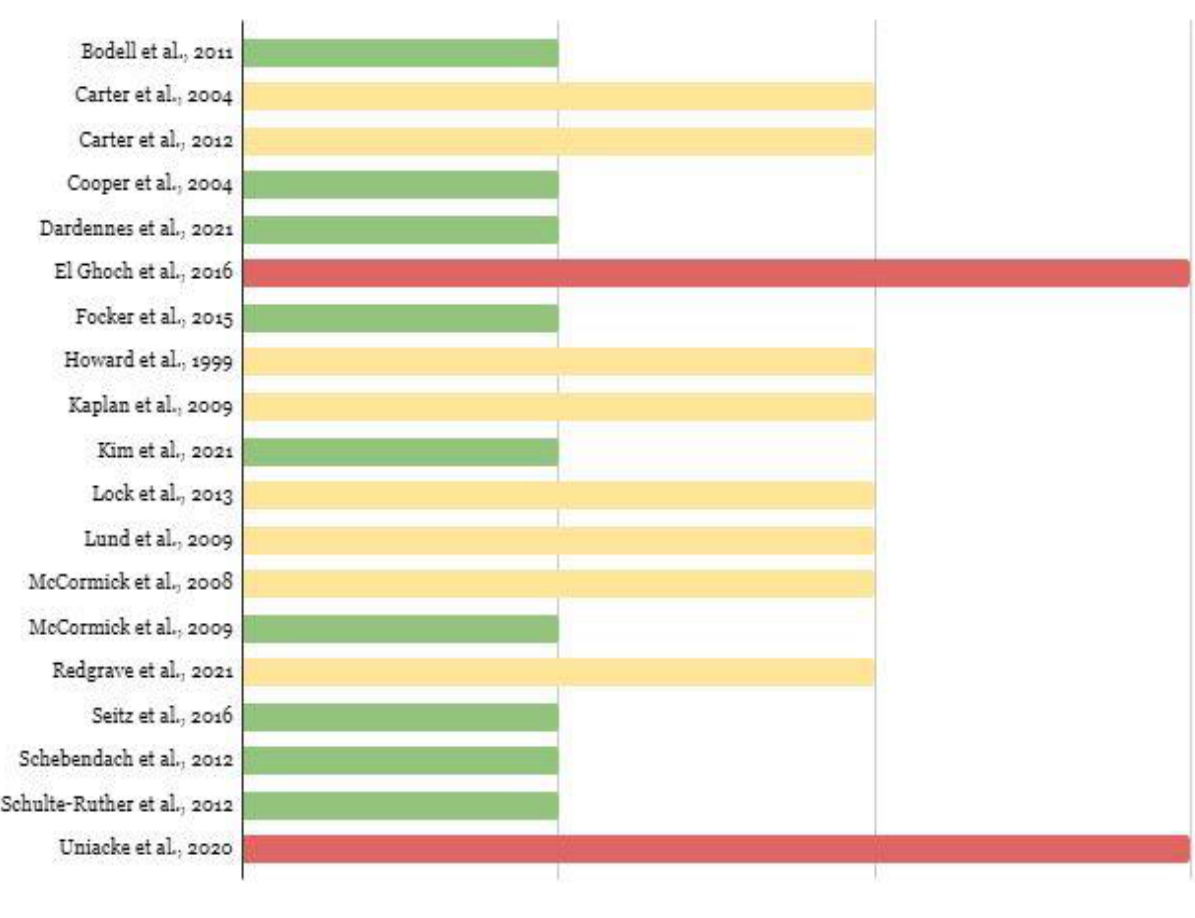
Figure 2. Risk of bias assessment for every individual study.